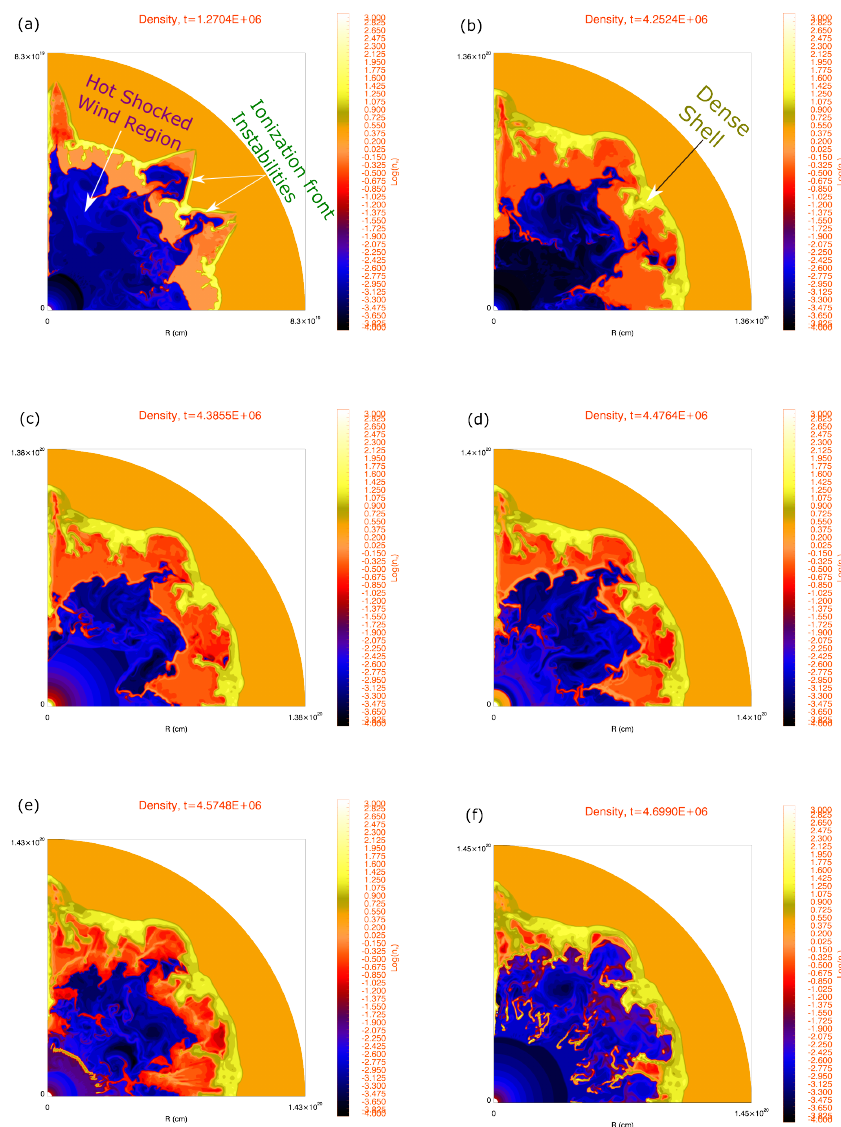
Figure 2. The density structure of the wind bubble from the 2D simulation. The scale in each panel is the logarithm of the number density n H , defined as n H = ρ / ( 1.67 × 10 − 24 ) where ρ is the gas density. The stellar evolution time in years is given at the top. Similar to Figure 1, panels ( a , b ) refer to the MS phase, panels ( c , d ) to the RSG phase, and panel ( e , f ) to the W-R phase. The hot shocked wind region (dark blue) becomes very asymmetric in shape as the simulation proceeds. The growth of ionization front instabilities in the MS phase, instabilities at the inner edge of the dense shell, and at the interface between the hot shocked wind region and the ionized HII region, is clearly seen, and is described in the